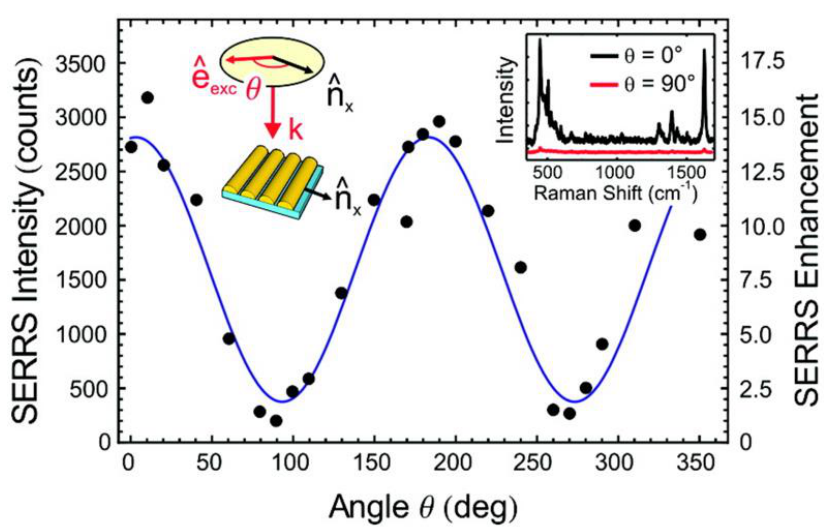
Figure 13. Unpolarized SERS intensity of methylene blue adsorbed on gold nanowires (NWs) versus excitation polarization 𝜃 as measured in a backscattering geometry. SERS intensity was found maximum for 𝜃 = 0° (inset, black line), i.e., for incident polarization vector (denoted as 𝑒 𝑒𝑥𝑐 ) parallel to the nanocavity axis 𝑛⃗ 𝑥 , and minimum for 𝜃 = 90° (inset, red line), i.e., 𝑒 𝑒𝑥𝑐 parallel to the NWs long axis 𝑛⃗ 𝑦 . The SERS intensity profile was well fitted with the ~ cos 2 𝜗 law (blue line), plus low order terms (Equation (63)). Excitation wavelength was 633 nm, thus the SERS spectrum is considered as a resonance one (SERRS). Adapted with permission from [43]. Copyright 2011 American Chemical Society.